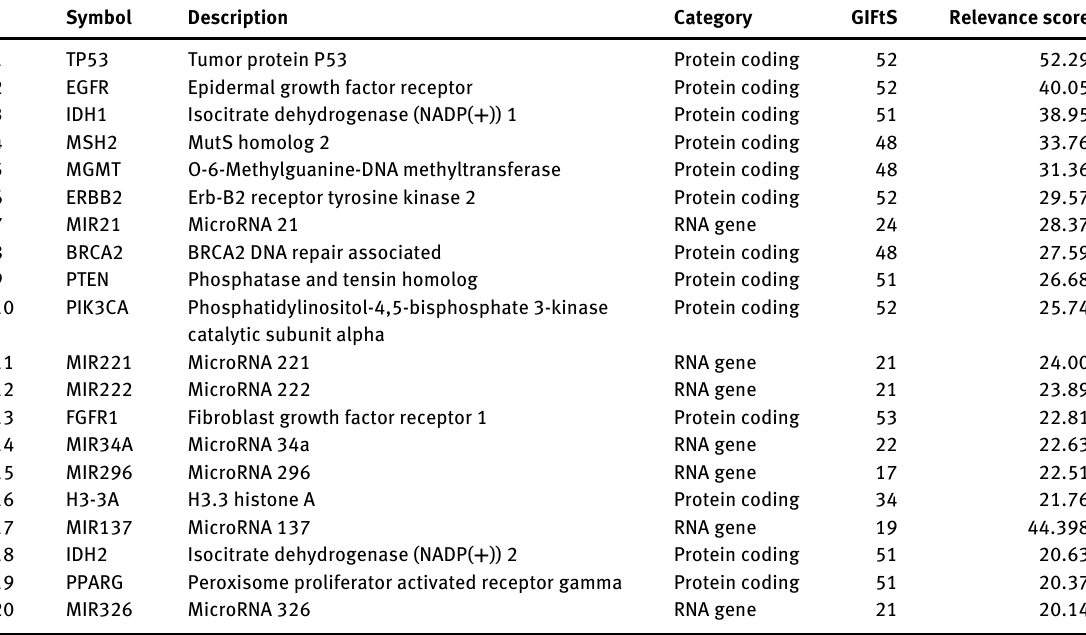
Table 4: Gene list for glioblastoma by GeneCards.